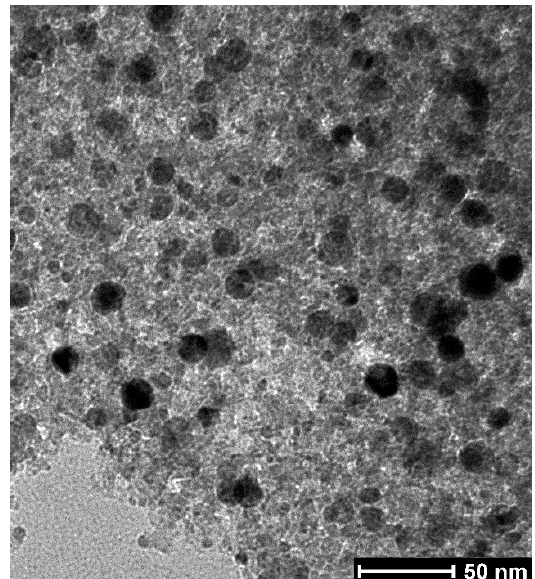
Figure 6. TEM micrograph of the 2TaSi5Ag NHSG catalyst.